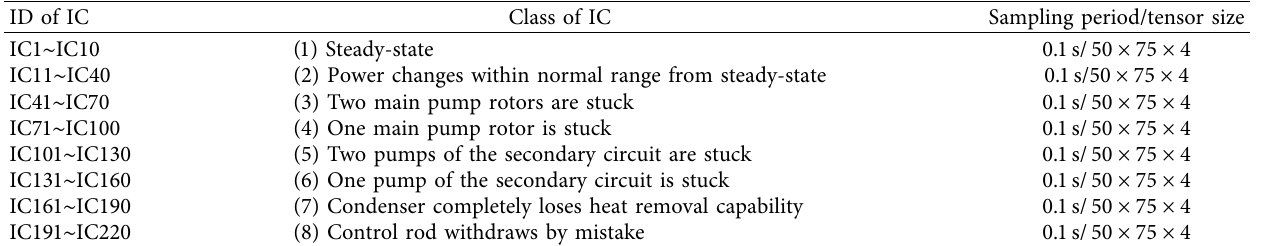
Figure 9: Hardware architecture based on IPC and DPU. Table 2: Simulation industry